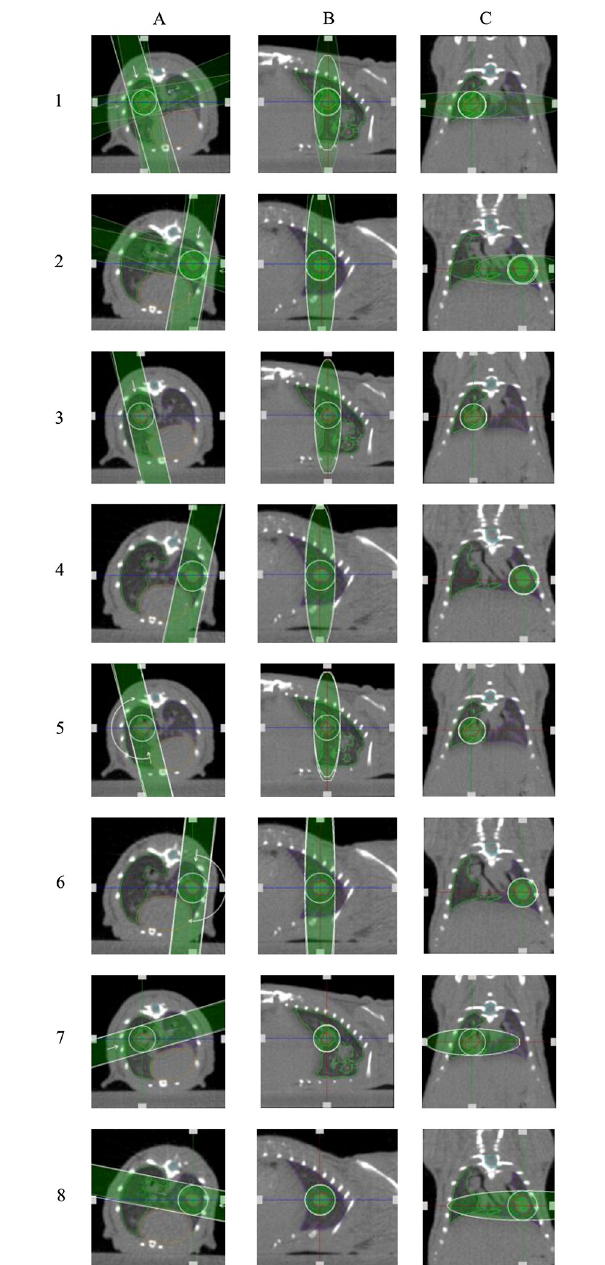
Fig 3. Treatment plans for both the left and right lung. The columns are views of the treatment plan from three visual axes, transversal (Column A), sagittal (Column B) and coronal (Column C). All the even numbered rows are plans which featured left lung lesions while all odd numbered rows are plans featured right lung lesions. The plans shown are 1) 2 sets of perpendicular staggered parallel opposed fields with avoidance of both spinal cord and heart (Row 1 & 2), 2) 2 fields positioned in APPA configuration (Row 3 & 4), 3) an 180˚ arc field from 0˚ to 180˚ (Row 5 & 6) and 4) 2 parallel opposed fields which crosses through the contralateral lung as well as the target with avoidance of both heart and spinal cord (Row 7 &